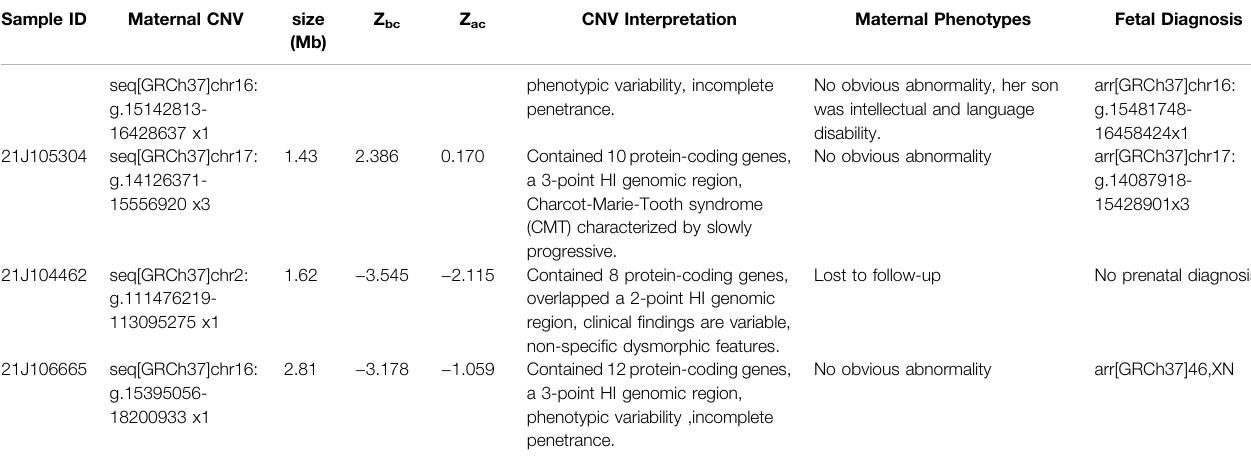
Maternal and fetal characteristics Age